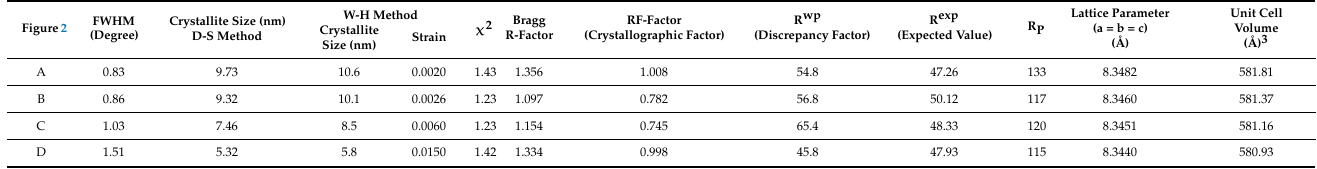
Table 1. Crystallite size, strain, various refinement parameters (goodness of fit, R-factor), lattice parameters, and unit cell volume of the AMF